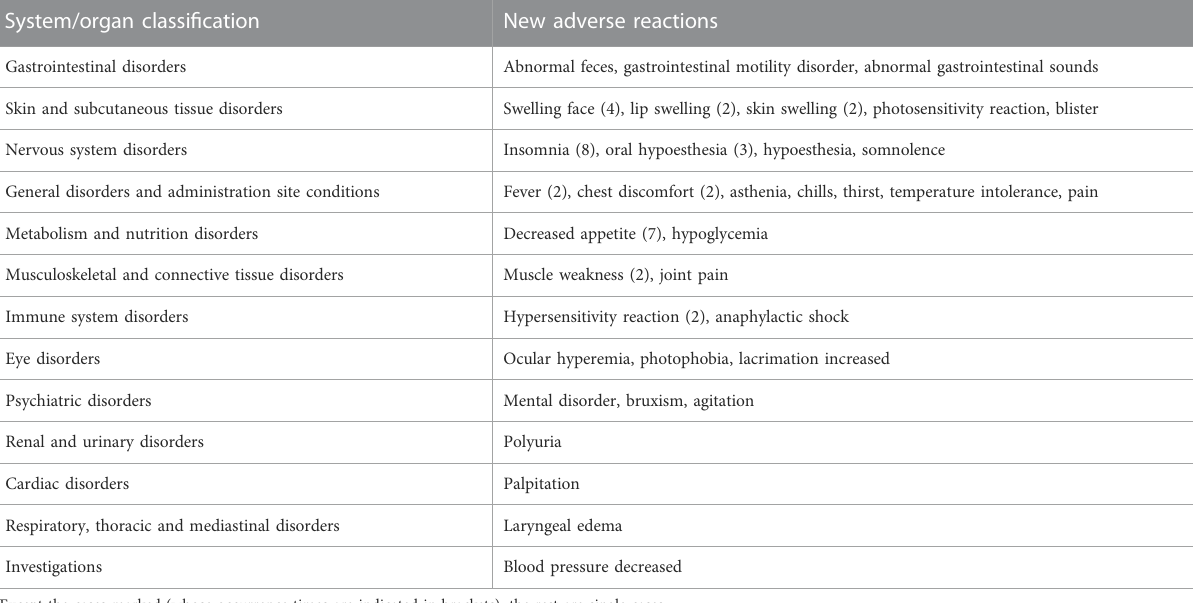
TABLE 7 Summary of nemonoxacin 500 mg safety in Phase II – IV studies strati fi ed in patients with abnormal liver and kidney functions a .